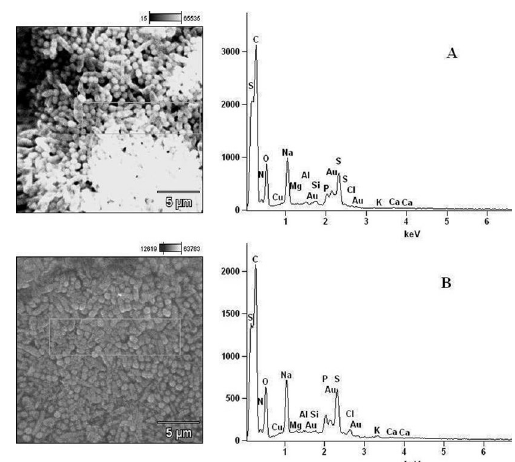
Fig. 10. Elemental components of (A) extract-untreated S. aureus and (B) extract-treated S. aureus